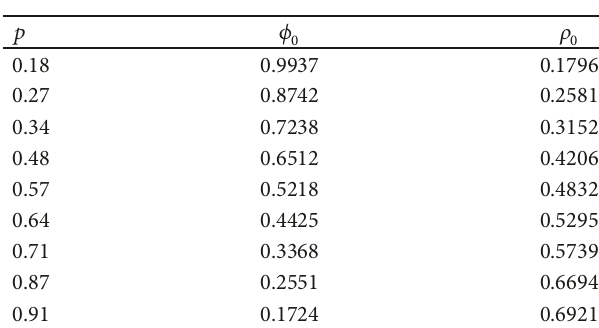
Table 1: The impact of fractional-order 𝑝 on the critical frequency